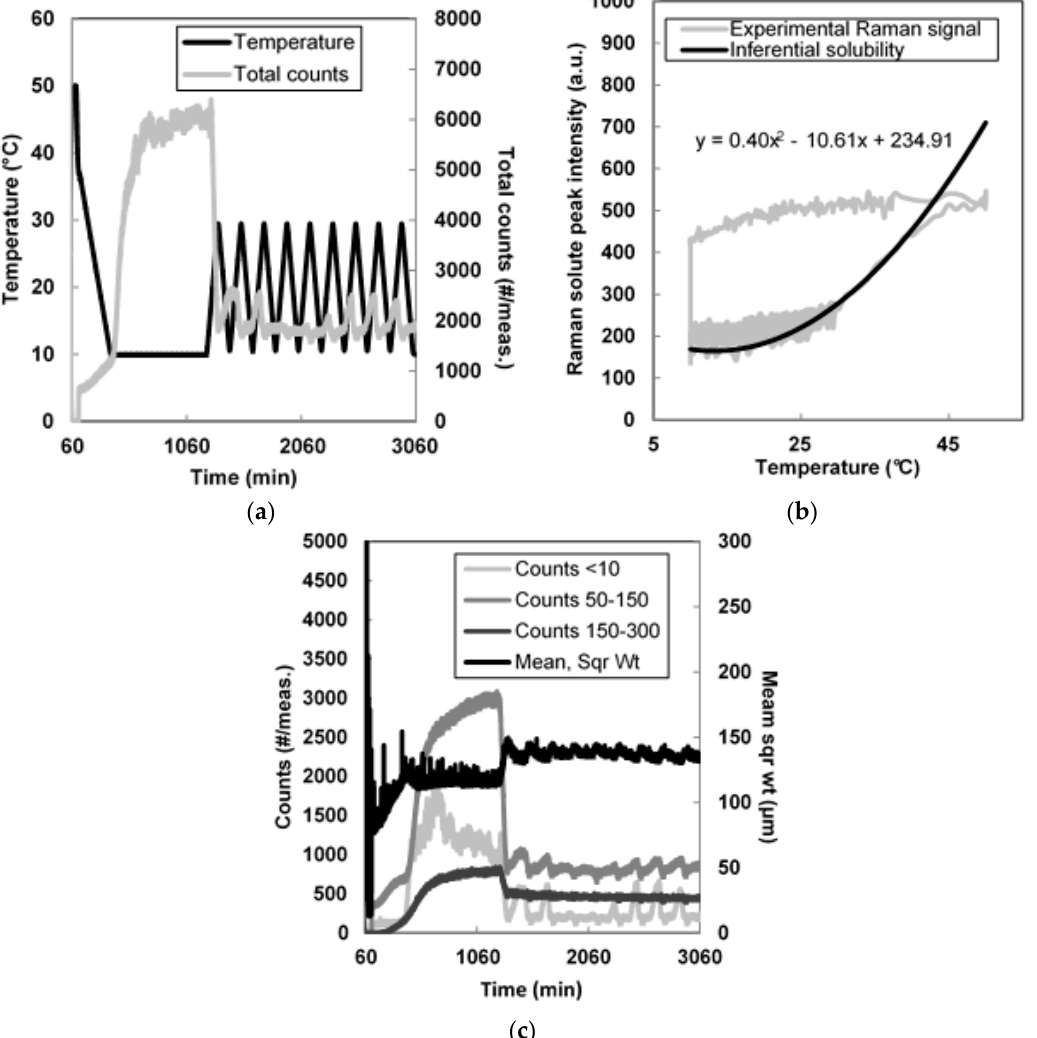
Figure 7. ( a ) Total counts and temperature during the seeded experiments with 2% membrane crystals; ( b ) Intensity of the Raman peak corresponding to dissolved piroxicam (solute); ( c ) Trends for FBRM (Focused Beam Reflectance Measurement) counts and mean of the square weighted chord length distribution.